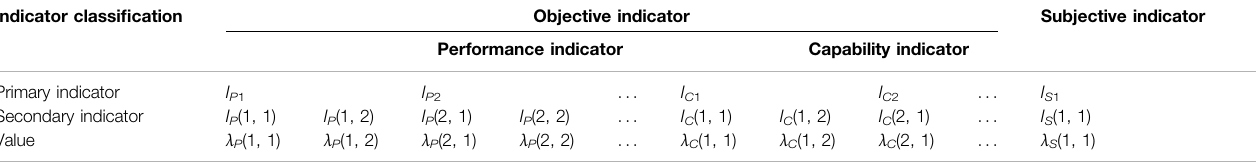
TABLE 1 | Multi-level service evaluation system. Indicator classi fi cation Objective indicator Subjective indicator Performance indicator Capability indicator